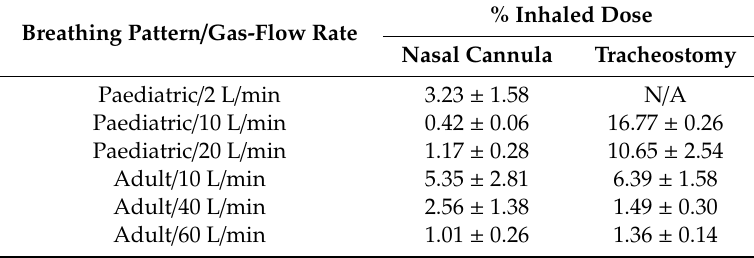
Table 1. Inhaled dose recorded during each nebulisation event using simulated adult and paediatric breathing profiles for the nasal cannula and tracheostomy interfaces, mean and standard deviations over the three events.